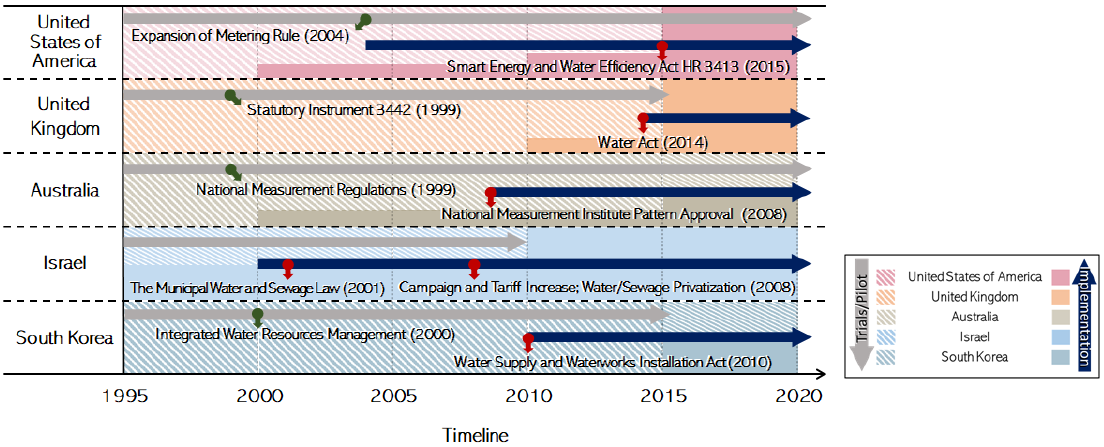
Figure 3. Major water policies impacting the implementation of smart water metering in selected countries.